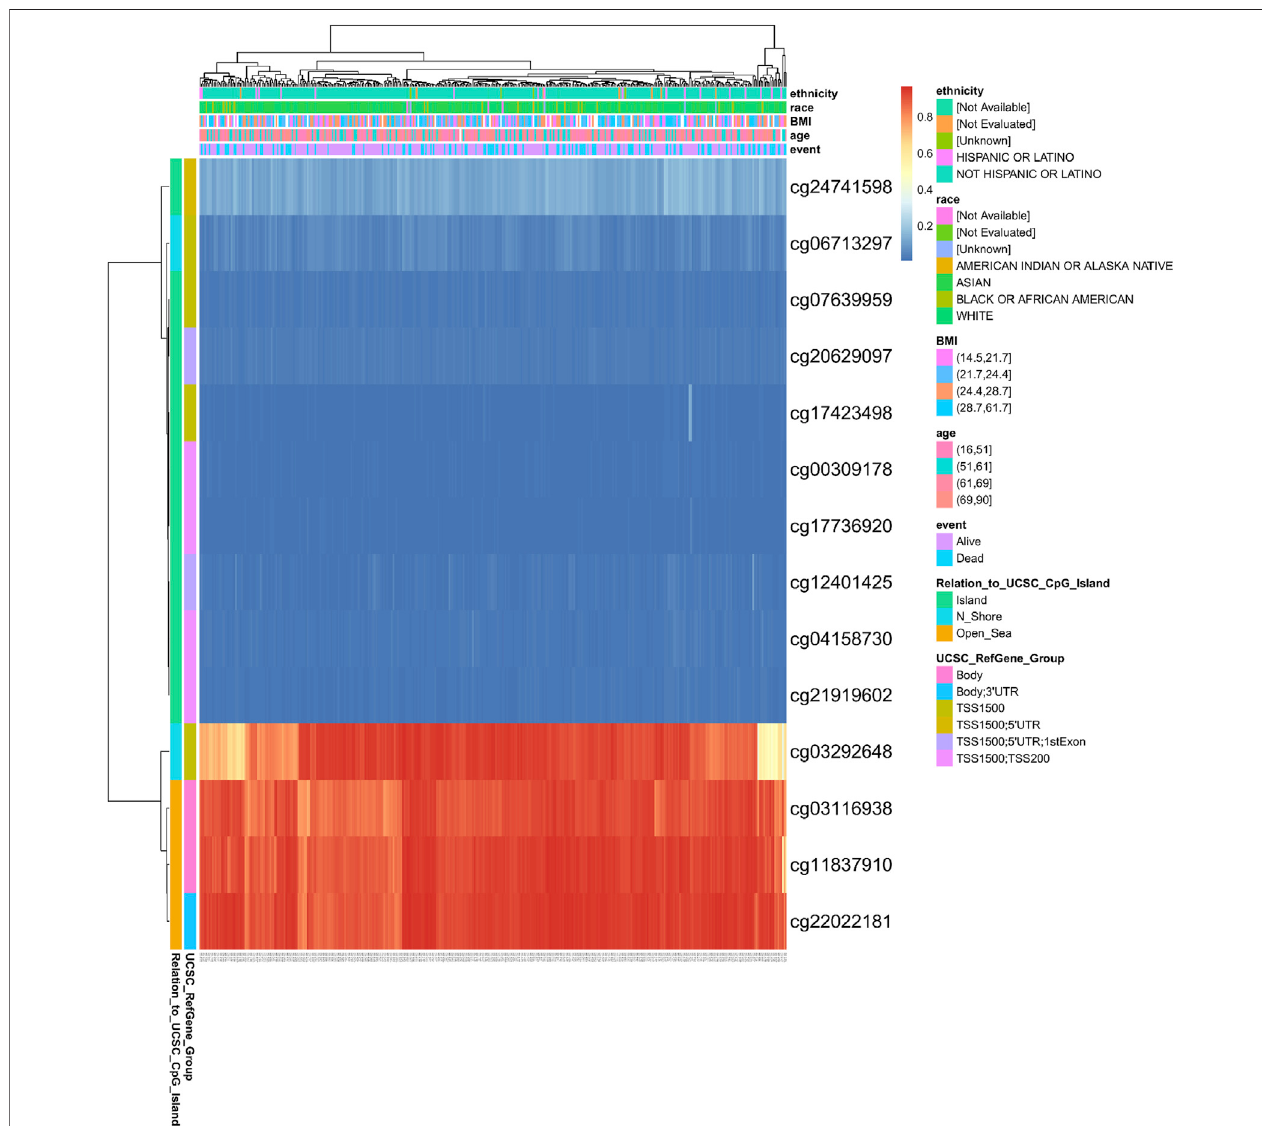
FIGURE 5 | DNA methylation levels in the EXO1 gene are associated with the prognosis of HCC patients.